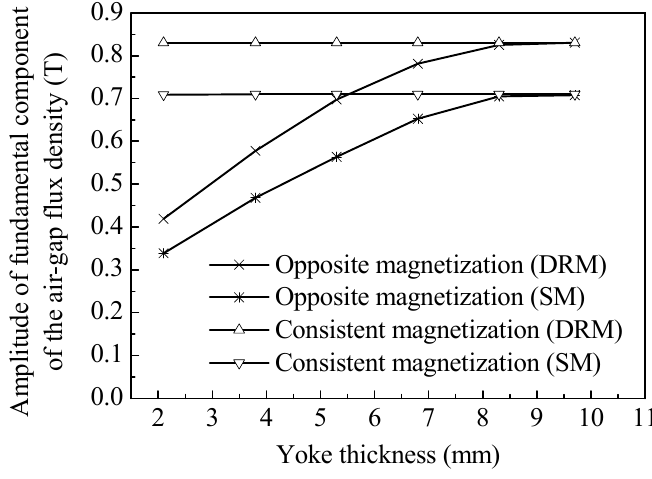
Figure 3. Amplitude of fundamental component of the DRM and SM air-gap flux density versus the thickness of the outer-rotor